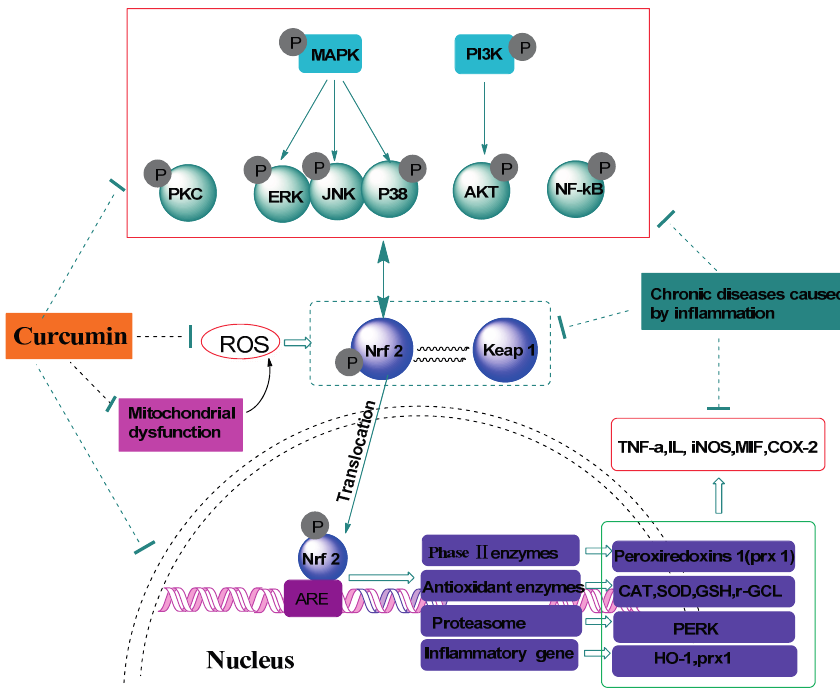
Figure 1. Inflammatory targets modulated by curcumin.